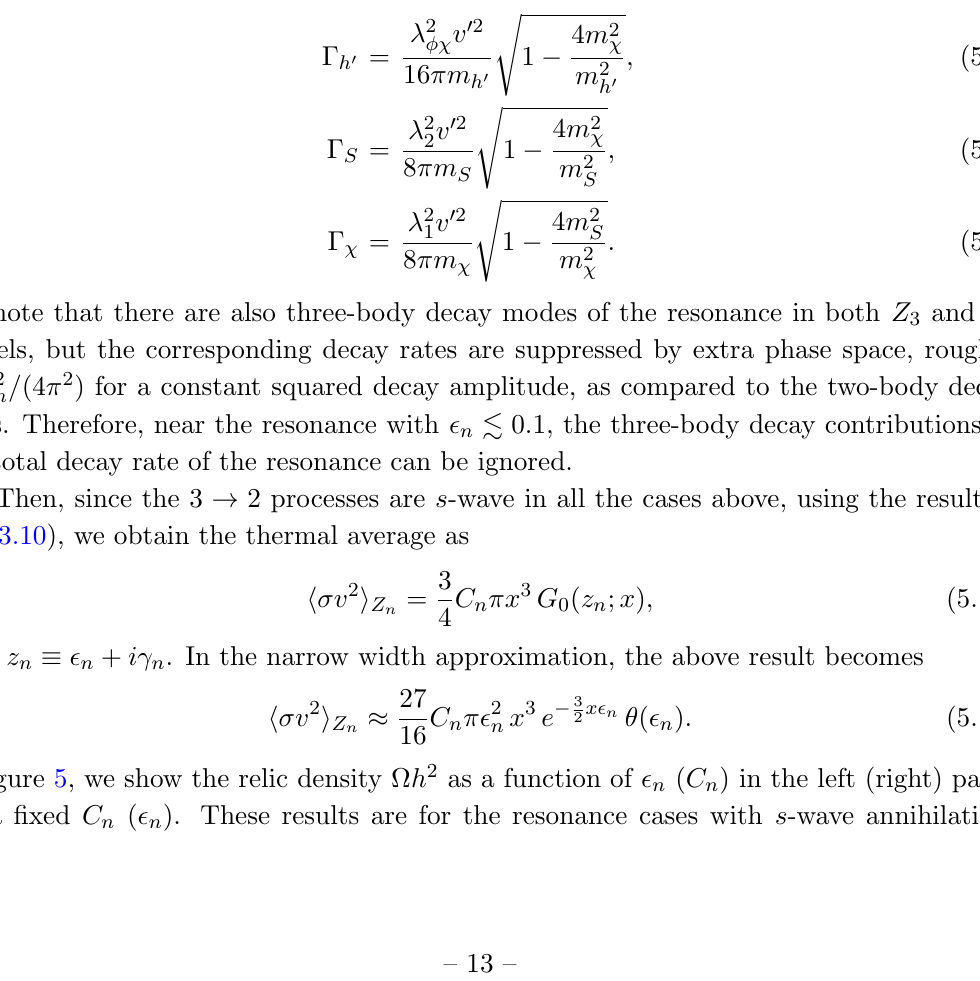
Figure 6 . Parameter space for DM cubic coupling vs mass, satisfying the relic density for Z n models. The results are shown in the narrow width approximation. (cid:20) for the Z 3 model can be replaced by (cid:21) 3 for the Z 5 model. (cid:15) n = 0 : 01 ; 0 : 02 ; 0 : 06 are chosen from top to bottom lines. h 0 ! (cid:31)(cid:31) (cid:3) in the Z case and S ! (cid:31) (cid:3) (cid:31) (cid:3) or (cid:31) ! SS in the Z case, as 3 5